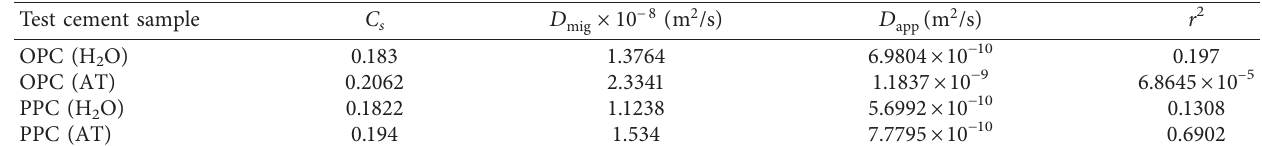
Table 3: C 2 values for test mortars in NaCl s , D mig , D app , and r